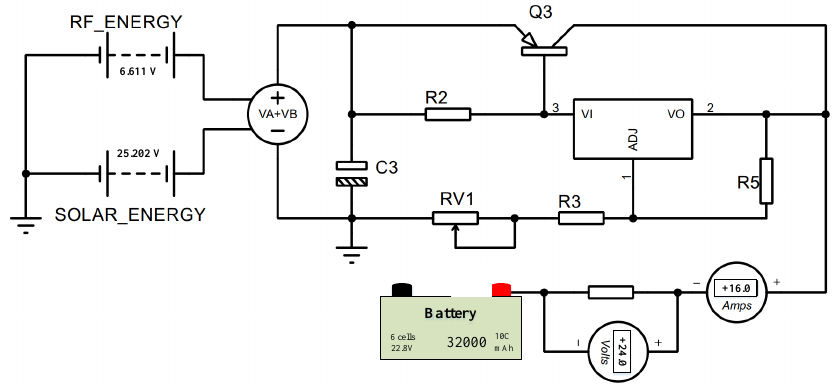
Figure 8. The charging system.